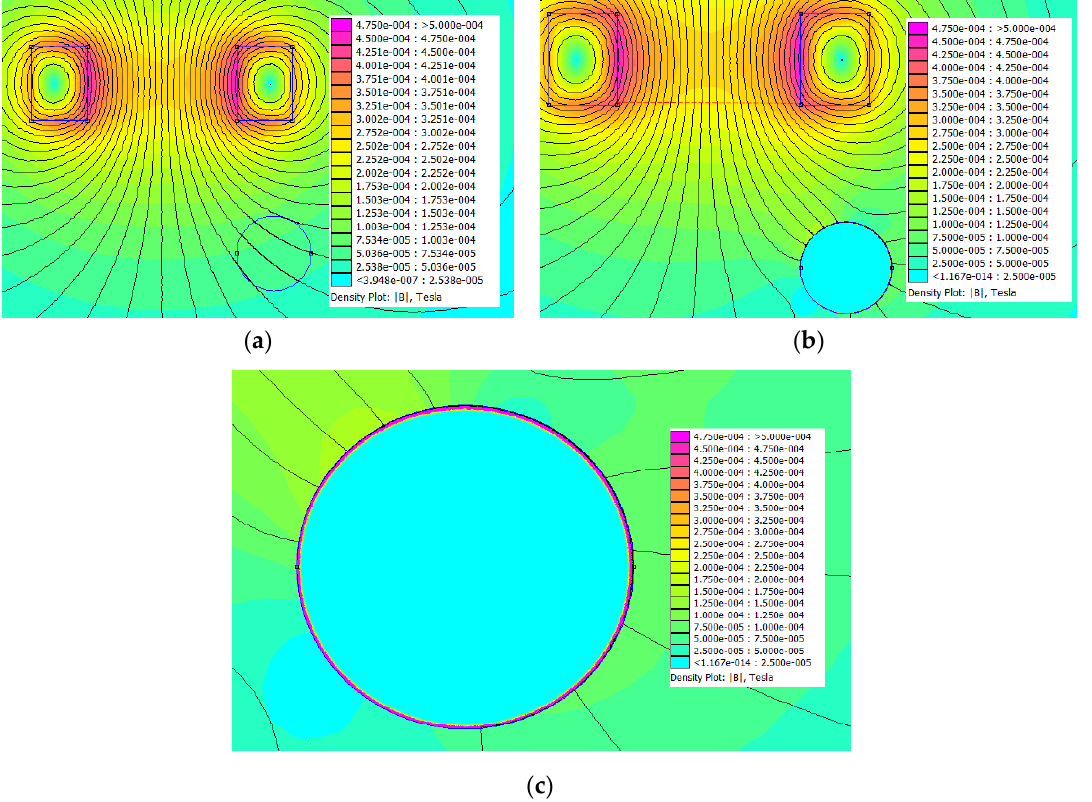
Figure 3. Simulation of the flux distribution under an ECT sensor. ( a ) Without the steel bar; ( b ) With the steel bar; ( c ) Details of the flux in the steel bar and region around it. Table 1. 2D components of the magnetic induction vector, with and without the steel bar.